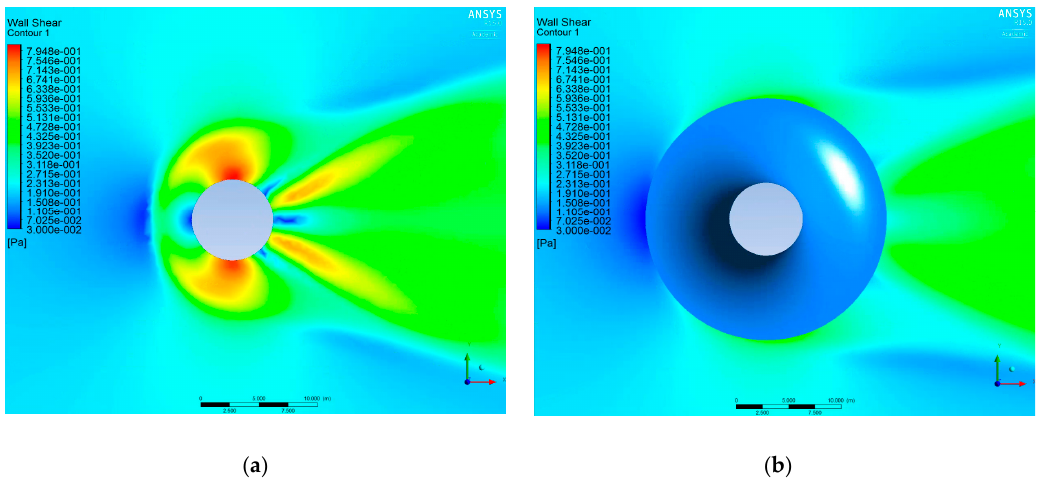
Figure 11. Shear stress on the surface of seabed: ( a ) before using the SEMCD; ( b ) after using the SEMCD